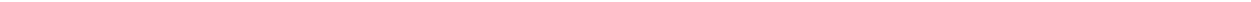
Fig. 4 Tumor-intrinsic activation of PPAR γ /RXR α is negatively correlated with immune in fi ltration. a Pathway enrichment analysis of genes differentially expressed in RXRA-S427Y, RXRA-S427F and PPARG overexpressing T24 lines relative to respective controls. Top suppressed pathways are shown. The analysis was based on three biological replicates. b Dot plot showing expression correlation of all genes with the curated immune signature (refer to “ Methods ” ) vs. correlation with PPARG in bladder tumors ( n = 385) from TCGA. c Heatmap presenting associations between RXRA mutations and PPARG expression with T-cell markers ( top, green label ), immune checkpoint molecules ( middle, yellow label ), and pro-in fl ammatory factors ( bottom, lavender label ) in TCGA MIBC ( n = 385). d IHC staining of PPAR γ and CD8 in two representative human bladder tumor samples from a clinical cohort ( n = 23, Eisai cohort). Scale bars: 100 μ m. e Summary of the IHC results of Eisai cohort shown in d . Distribution of CD8+ T-cell in fi ltration in bladder tumors expressing high (scores 2 – 4) or low (score 1) levels of PPAR γ protein. f Whisker plot representing IHC staining of in fi ltrating CD8+ T cells and PPAR γ